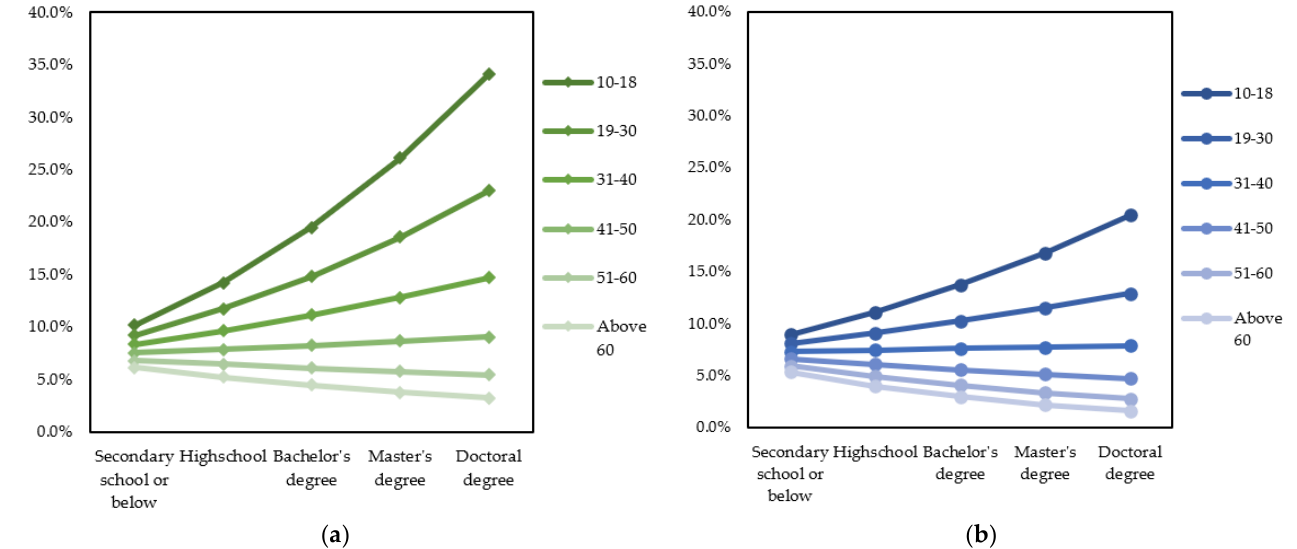
Figure 7. Probabilities to have domestic migration intention based on educational level and age group. ( a ) Male urban inhabitants; ( b ) female urban inhabitants.